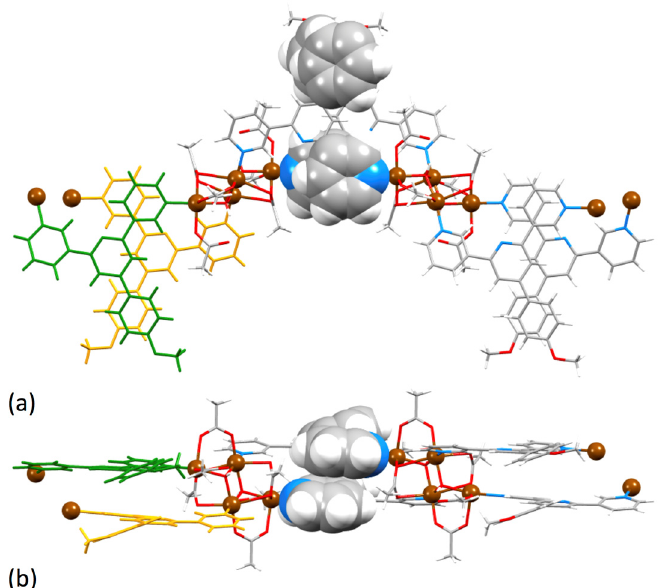
Figure9. ( a )Partofonedouble-strandedchainin{[Cu 4 ( µ 3 -OH) 2 ( µ -OAc) 2 ( µ 3 -OAc) 2 (AcO- κ O ) 2 ( 1 ) 2 ] · 2MeOH} n Figure 9. ( a ) Part of one double-stranded chain in (solvent omitted) showing π -stacking of pairs of phenyl and pairs of pyridine rings (space-filling {[Cu 4 ( μ 3 -OH) 2 ( μ -OAc) 2 ( μ 3 -OAc) 2 (AcO- κ O ) 2 ( 1 ) 2 ] . 2MeOH} n (solvent omitted) showing π -stacking of representation) an, in green and orange, the relative orientations of stacked ligands 1 . ( b ) The chain in pairs of phenyl and pairs of pyridine rings (space-filling representation) an, in green and orange, the diagram (a) viewed through the relative orientations of stacked ligands 1 . ( b ) The chain in diagram (a) viewed through the double-strand.